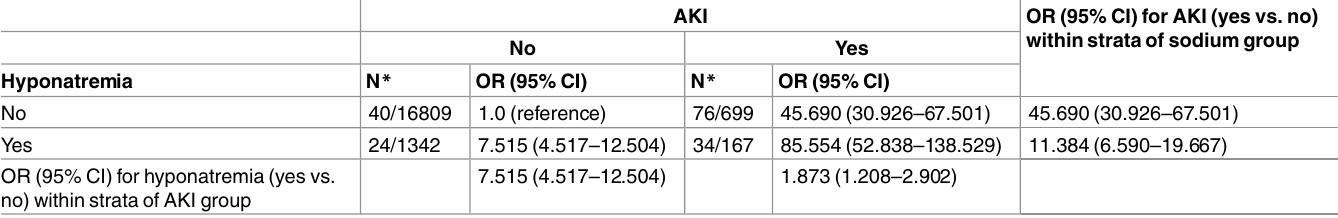
Table 4. Interaction analysisbetweenhyponatremia and acutekidney injuryfor the in-hospital mortality.